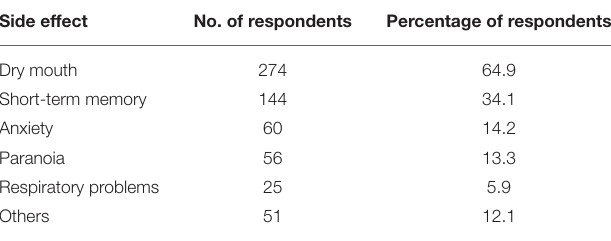
TABLE 1 | Side effects experienced by survey participants from consumption of WMMC strains and products ( n = 442) * .